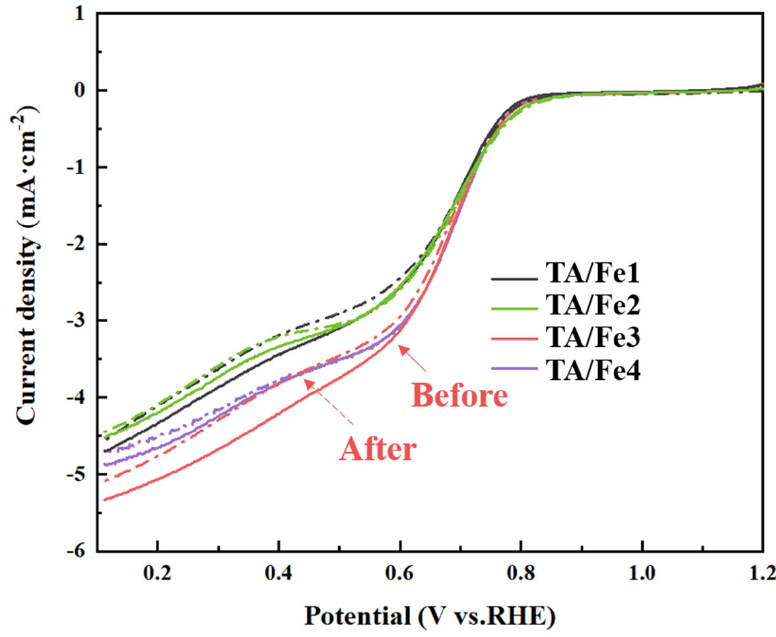
Figure 9. LSV curves and stability of the titanium oxide ‐ based aerogel catalysts doped by different